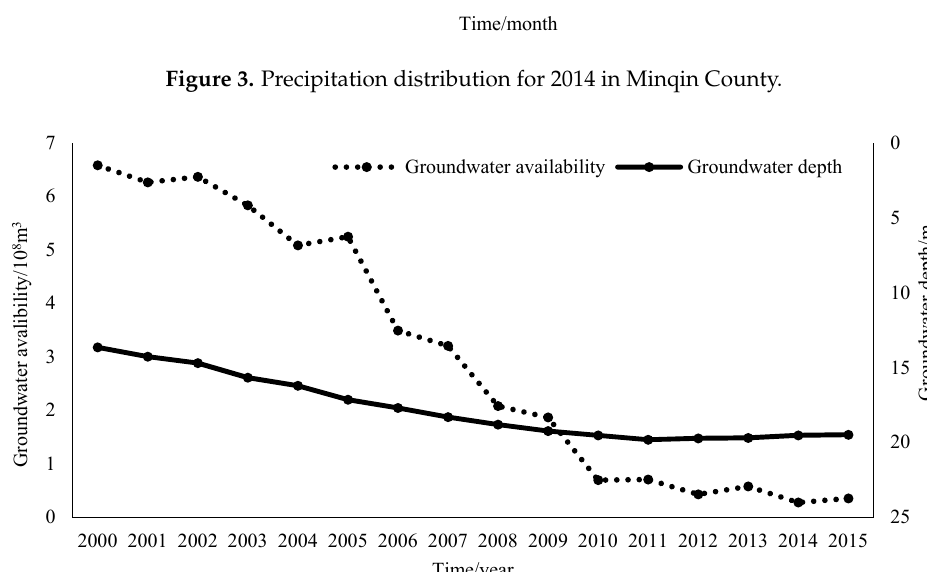
Figure 4. Groundwater availability and groundwater depth from 2000–2015 in Minqin County.